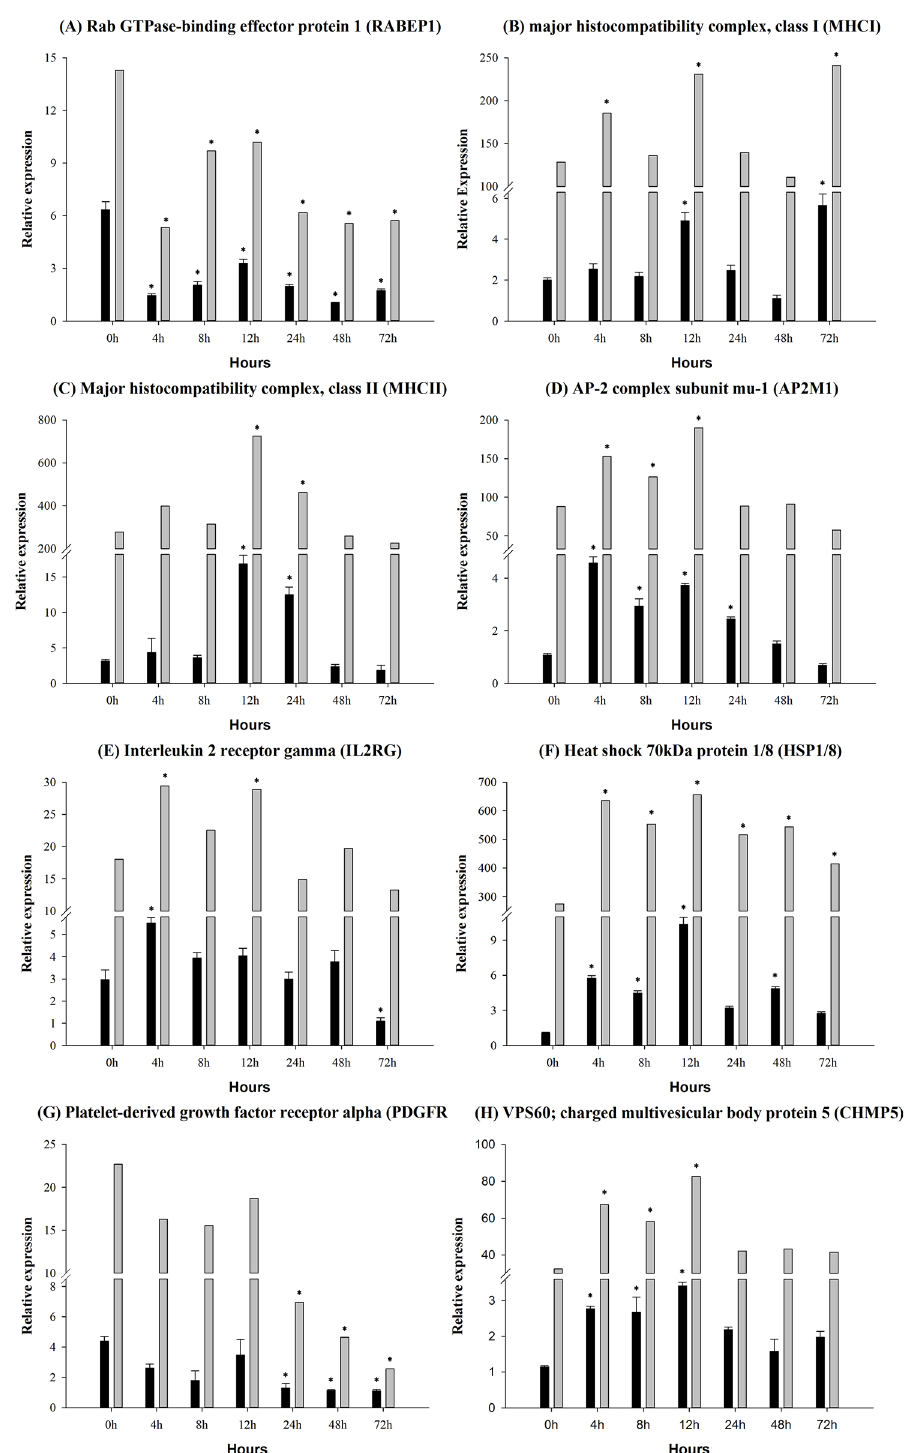
Fig 8. Endocytosis-related pathway gene expression in control and experimental group intra- peritoneal injection with 2.7×10 7 CFU/mL (100 μ L/fish) Aeromonas hydrophila , as determined by qRT-PCR. (A) RABEP1, (B) MHCI, (C) MHCII, (D) AP2M1, (E) IL2RG, (F) HSP1/8, (G) PDGFRA, (H) CHMP5. The black and the gray column represent selected gene and sequencing data, respectively. Values are presented as the mean ± SD (n = 6). The expression levels with * indicate significant differences with control group (p <